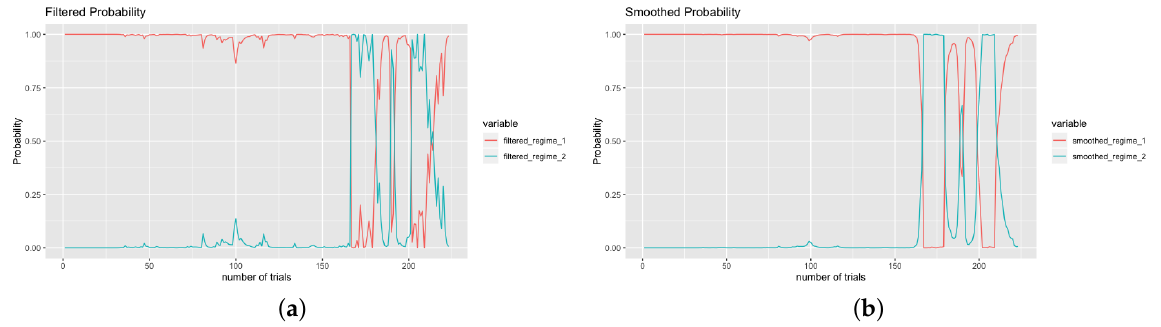
Figure 13. ( a ) The filtered and ( b ) smoothed probabilities for energy-switching